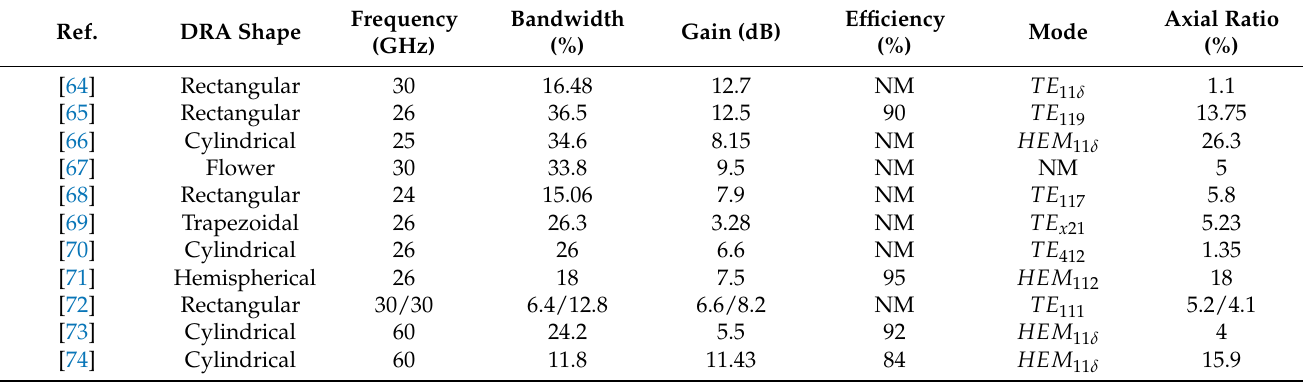
Table 5. Comparison between the performance of circularly polarized DRAs.